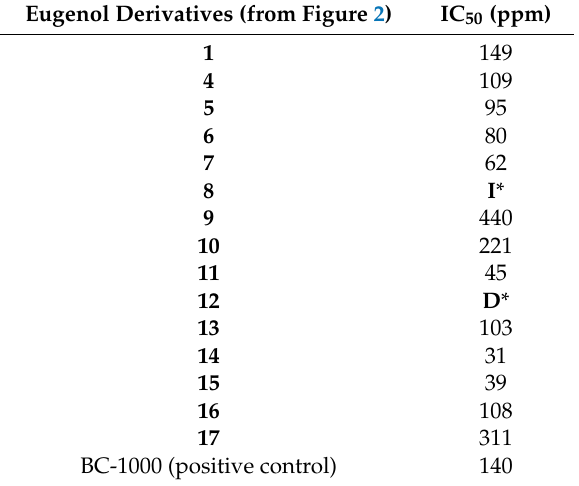
Table 1. IC 50 values of eugenol and its synthetic derivatives on in vitro mycelial growth of B. cinerea . These values were estimated by measuring the colony diameter after 48 h of incubation.